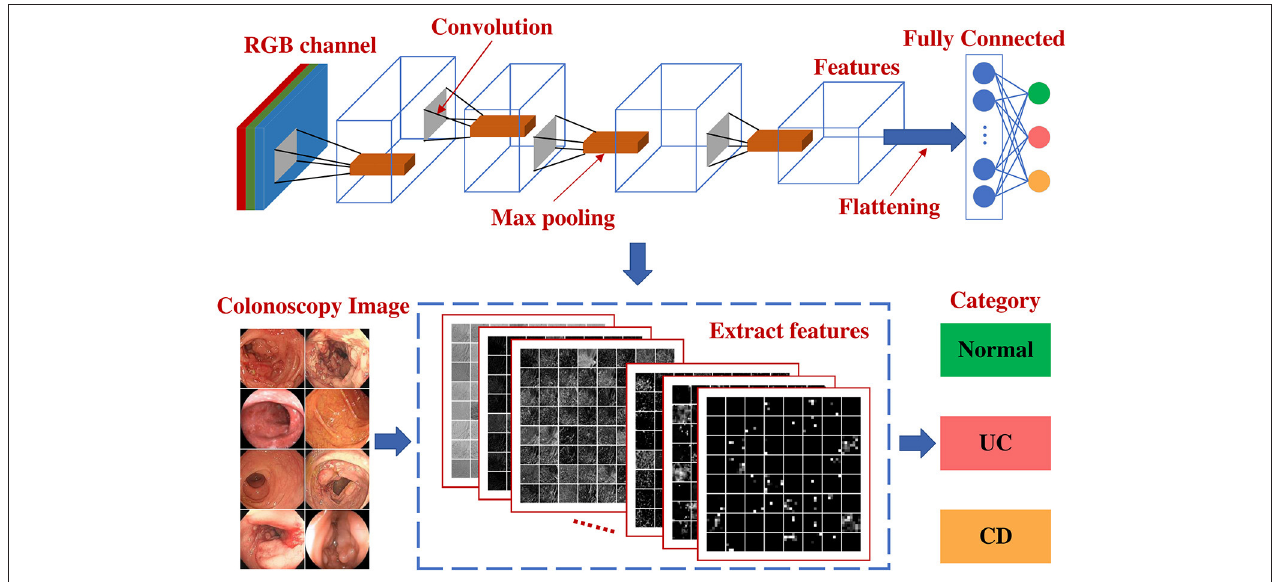
FIGURE 1 | Graphic abstract of the study.